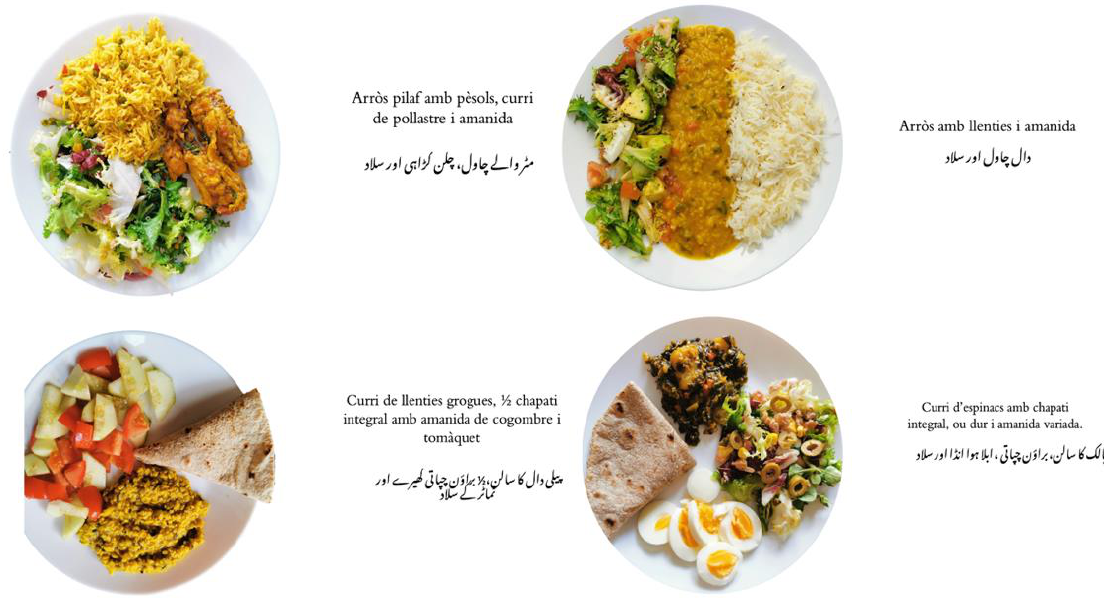
Figure 3. Examples of healthy plates elaborated with traditional Pakistani food.